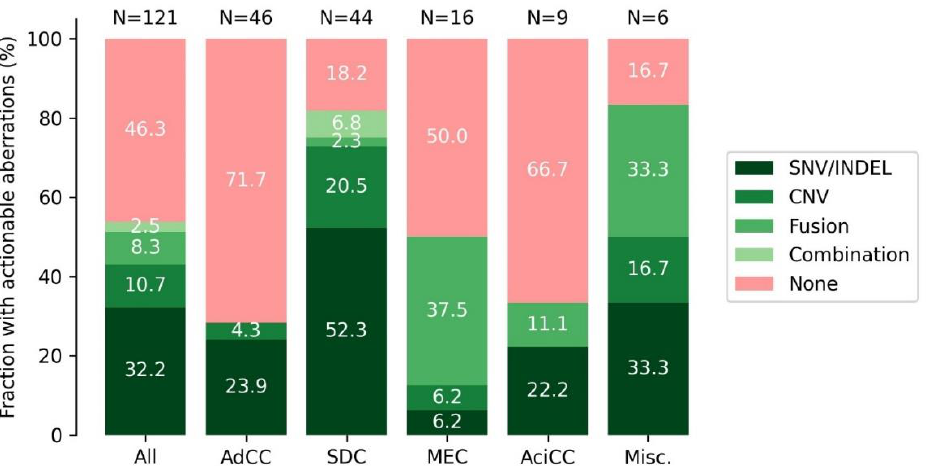
Figure 5. Fraction of cases with putatively actionable aberrations, split per subtype and type of aberration. The SNV/INDEL group for SDC contains one SDC case on which actionability was based solely on high TMB and one SDC case with MSI. Abbreviations: SDC: salivary duct carcinoma, AdCC: adenoid cystic carcinoma, MEC: mucoepidermoid carcinoma, AciCC: acinic cell carcinoma, misc.: miscellaneous; SNV: single nucleotide variant, INDEL: insertion/deletion; CNV: copy number variant; TMB: tumor mutational burden; MSI: microsatellite instability.